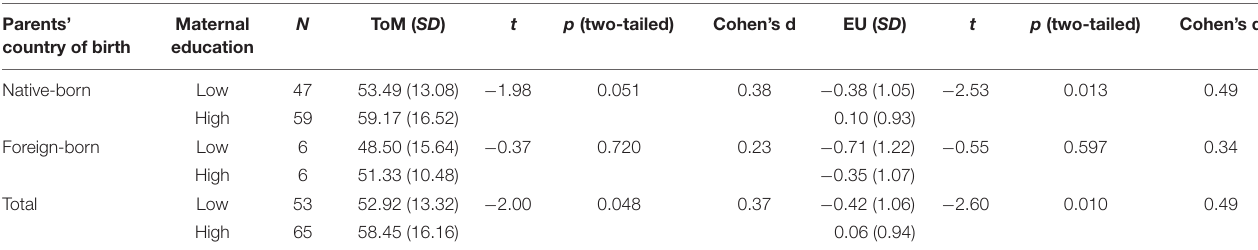
TABLE 4 | Differential effect of maternal education in children as a function of having native-born versus foreign-born parents. Parents’ country of